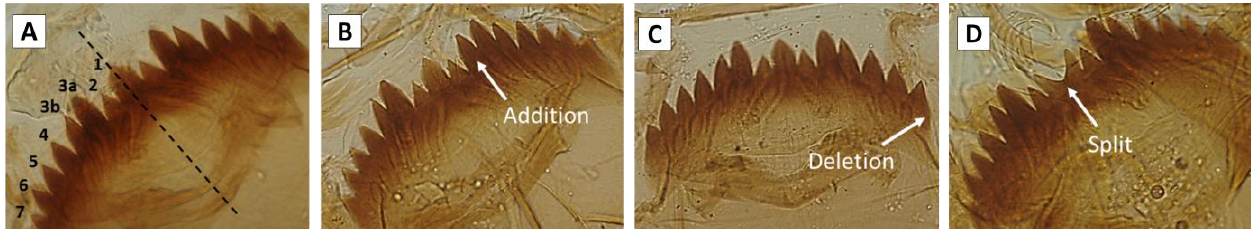
Figure 1. Microscopic observations of the mentum of Chironomus larvae (× 400). ( A ) Non-deformed mentum; teeth are numbered from 1 to 7 following a symmetry axis indicated by the dashed black line. ( B ) Tooth addition (between No. 3b and 4). ( C ) Tooth deletion (No. 7). ( D ) Split of central tooth.